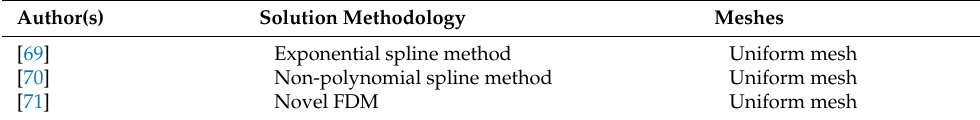
Table 7. Various methods and mesh used to solve Equations (9) and (10).